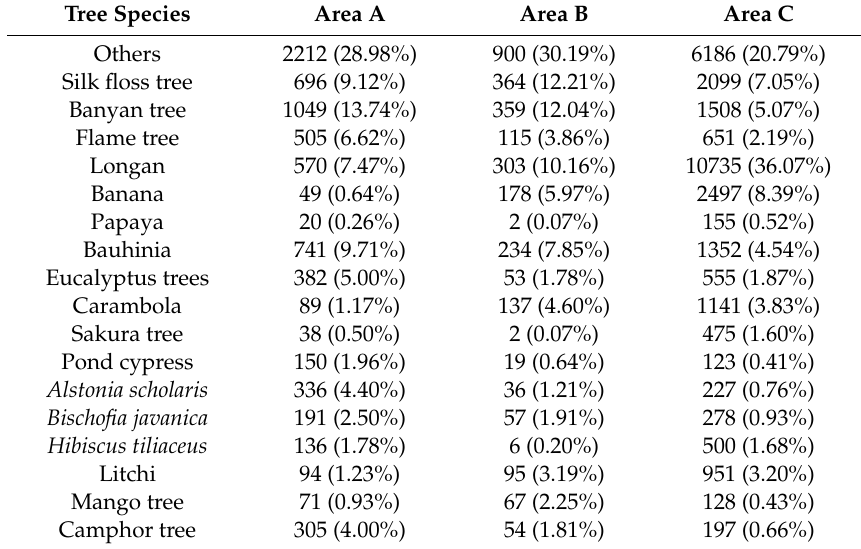
Table 3. Proportion of di ff erent tree species in each area according to the classification results of VGG16. Tree Species Area A Area